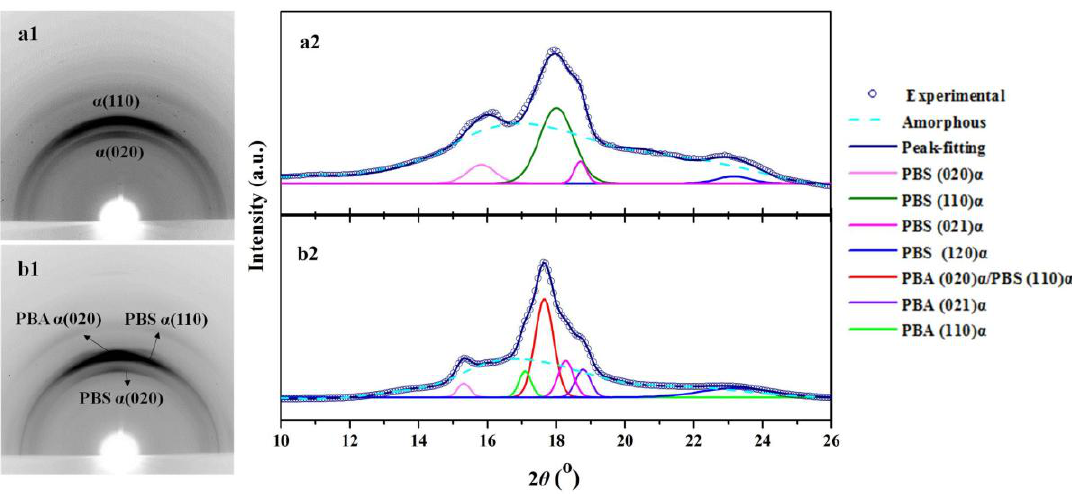
Figure 7. Typical 2D WAXD patterns of ( a1 ) oriented PBS film, ( b1 ) PBA crystallized at 25 °C on the oriented PBS substrates, and their corresponding intensity profiles of ( a2 , b2 ).